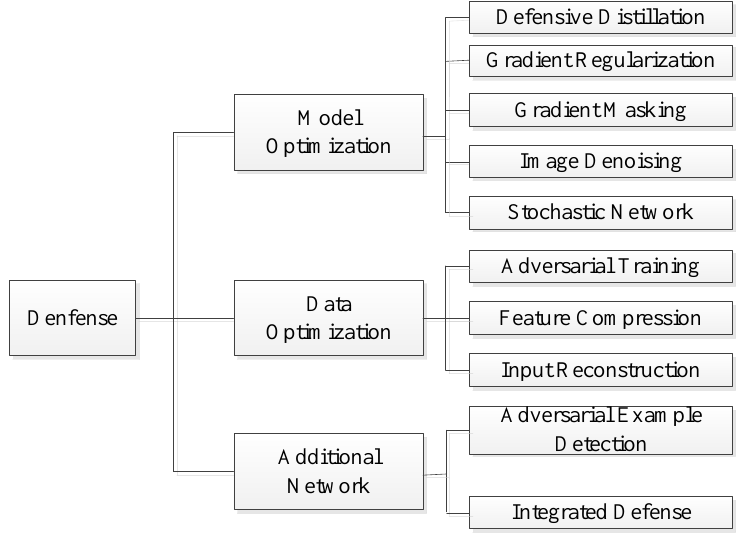
Figure 3. Adversarial Attack Defense Methods of Deep Neural Networks.